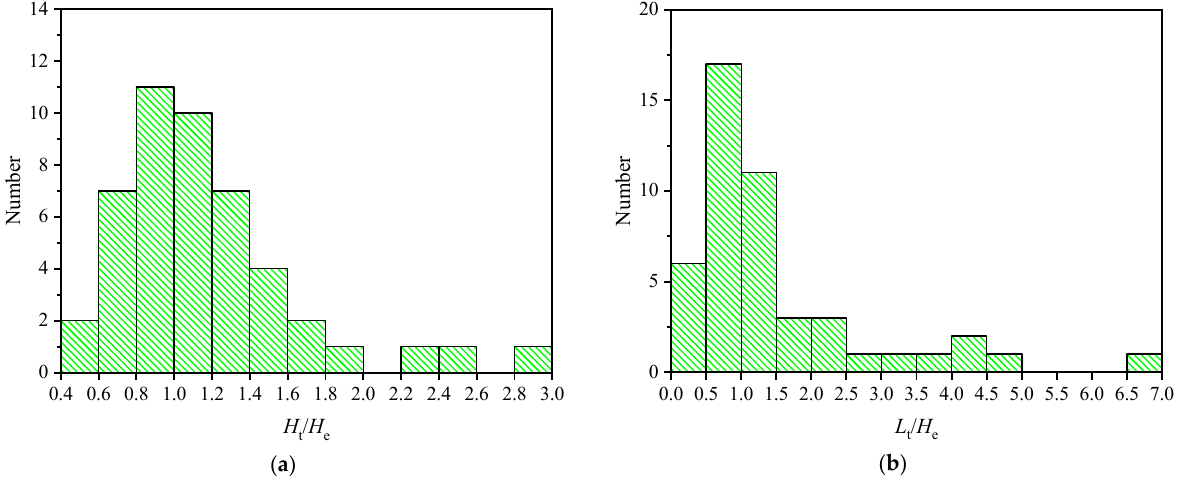
Figure 3. Histogram of relative position between the tunnel and deep excavation: ( a ) Histogram of vertical tunnel position; ( b ) Histogram of tunnel horizontal position.